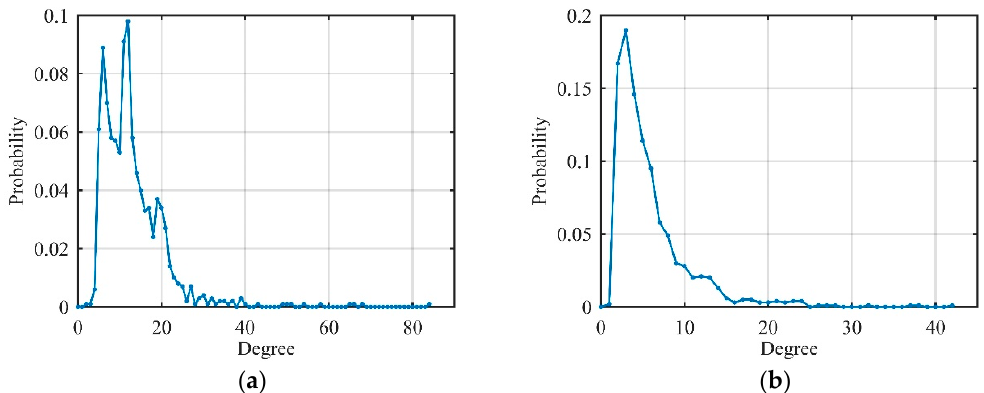
Figure 10. Degree distribution of jamming signals on visibility graphs (jamming-to-noise ratio (JNR) = 10 dB). ( a ) Interrupted-sampling repeater jamming (ISRJ); ( b ) noise productive jamming (NPJ).